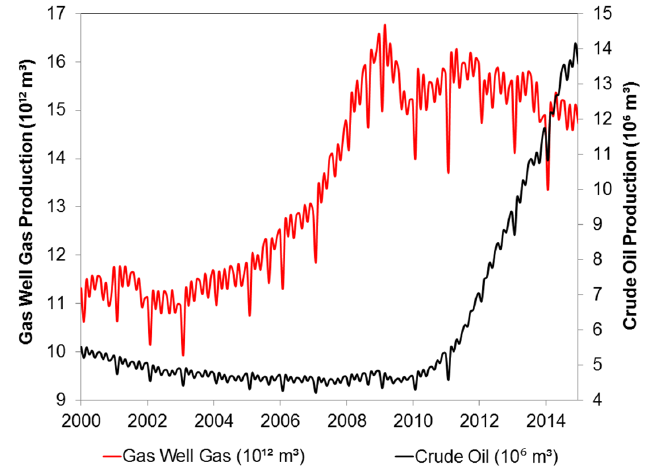
Figure 3. While gas production began to increase in the early 2000s in Texas, this study captures water transactions prior to 2009 due to the increases in oil production beginning in 2009 and 2010. (Figure created by the authors based on data from [23]).